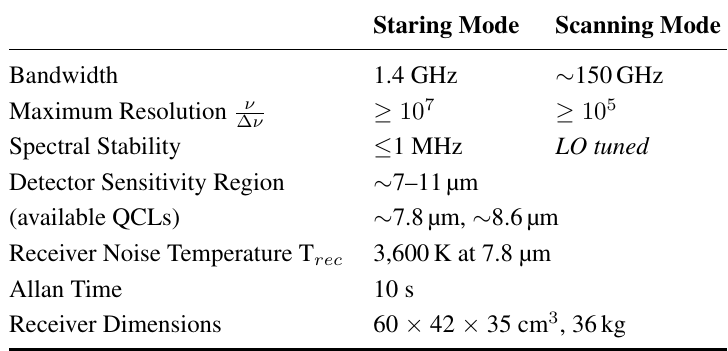
Table 1. List of important specifications for Infrared Compact Heterodyne Instrument for Planetary Science (iChips).